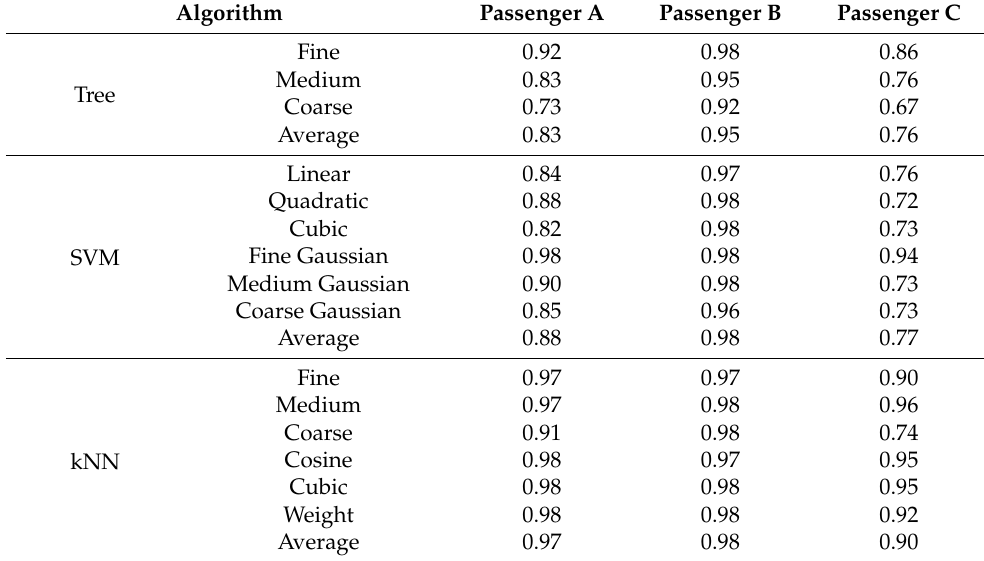
Table 4. Training AUC of all